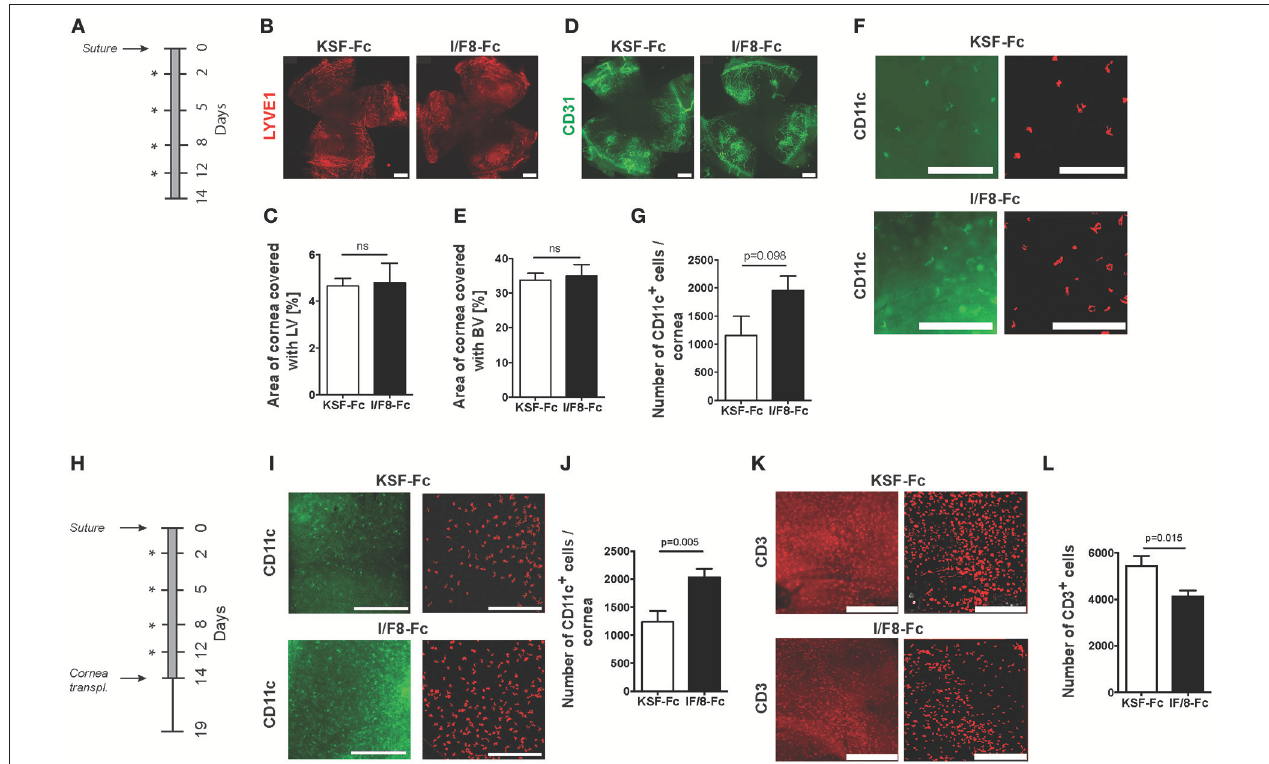
FIGURE 6 | ALCAM blockade results in accumulation of corneal DCs. (A) Schematic description of the suture model. Three sutures were placed into the corneas. Mice received I/F8-Fc or KSF-Fc control antibody i.p. (150 µ g) on day 2, 5, 8, and 12 (indicated by an asterisk) as well as antibody-containing eye drops (3 µ g) twice a day for 14 days (gray bar). Corneas were analyzed by whole-mount immunofluorescence on day 14 ( n = 5/group). (B–G) Representative immunofluorescence images and quantifications of the percentage of corneal area covered with (B,C) LYVE-1 + lymphatic vessels (LVs), (D,E) CD31 + blood vessels (BVs), scale bars: 500 µ m, and (F,G) CD11c + DCs, scale bars: 100 µ m. Images on the left in (F) show CD11c + cells (green) detected by immunofluorescence. Images on right show corresponding cells (red) identified by gray-image threshold analysis, which was used for quantification (G) . (H) Schematic representation of the suture/allograft model: three sutures were placed into the corneas and animals were treated as in (A) . On day 14 corneal transplantation was performed. Five days after transplantation (day 19), corneas were analyzed by whole-mount immunofluorescence ( n = 10/group). (I–L) Representative images and quantifications of the percentage of corneal area covered with (I,J) CD11c + DCs and (K,L) CD3 + T cells. DC and T cell quantification in (I–L) was performed as in (F,G) . Images on the left in (I,K) depict DC and T cells as seen in immunofluorescence; images on the right (in red) as identified by gray-image threshold analysis. Scale bars: 100 µ